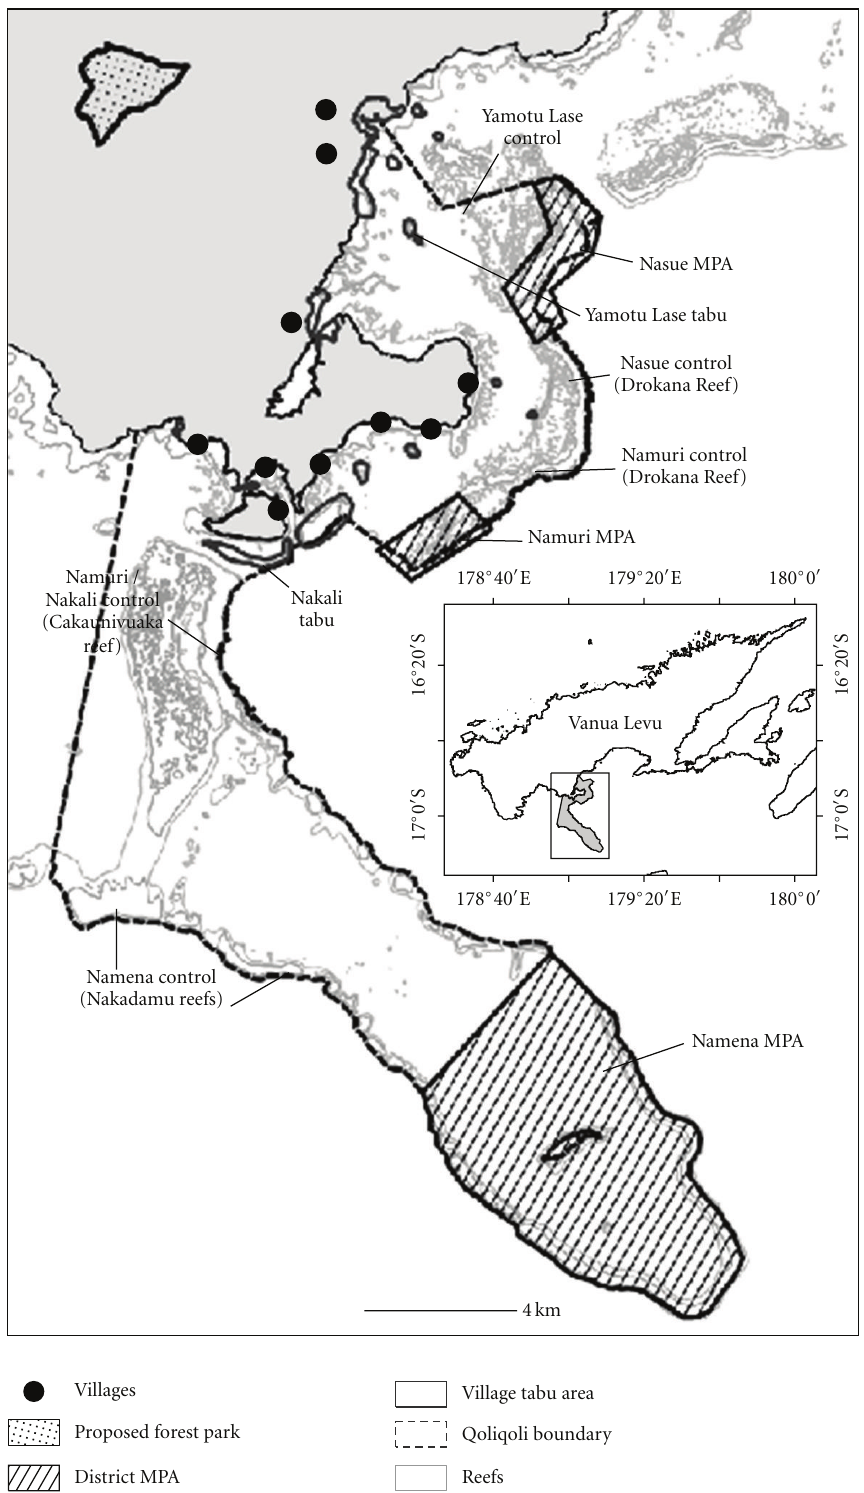
Figure 1: Location of MPAs, tabu areas, and adjacent fished areas used as control sites within the Kubulau traditional fishing grounds. Inset map shows the location of Kubulau qoliqoli on Vanua Levu,